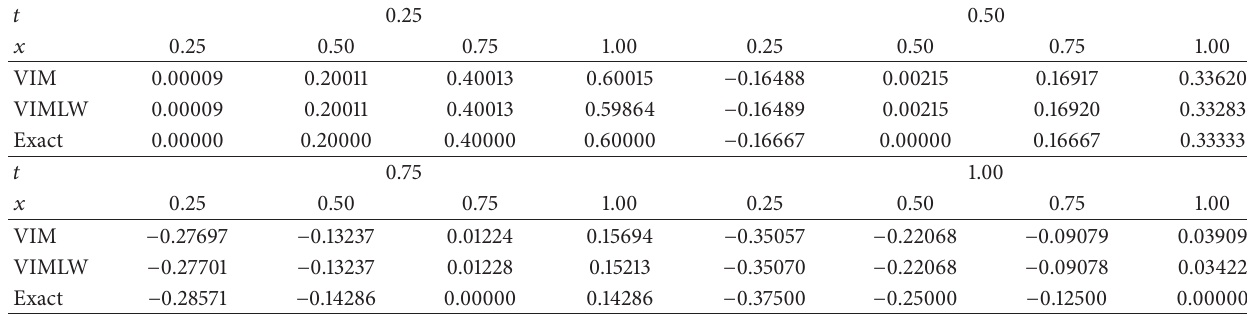
Table 4: Numerical values when 𝑡 = 0.25 , 0.50, 0.75, and 1.0 for